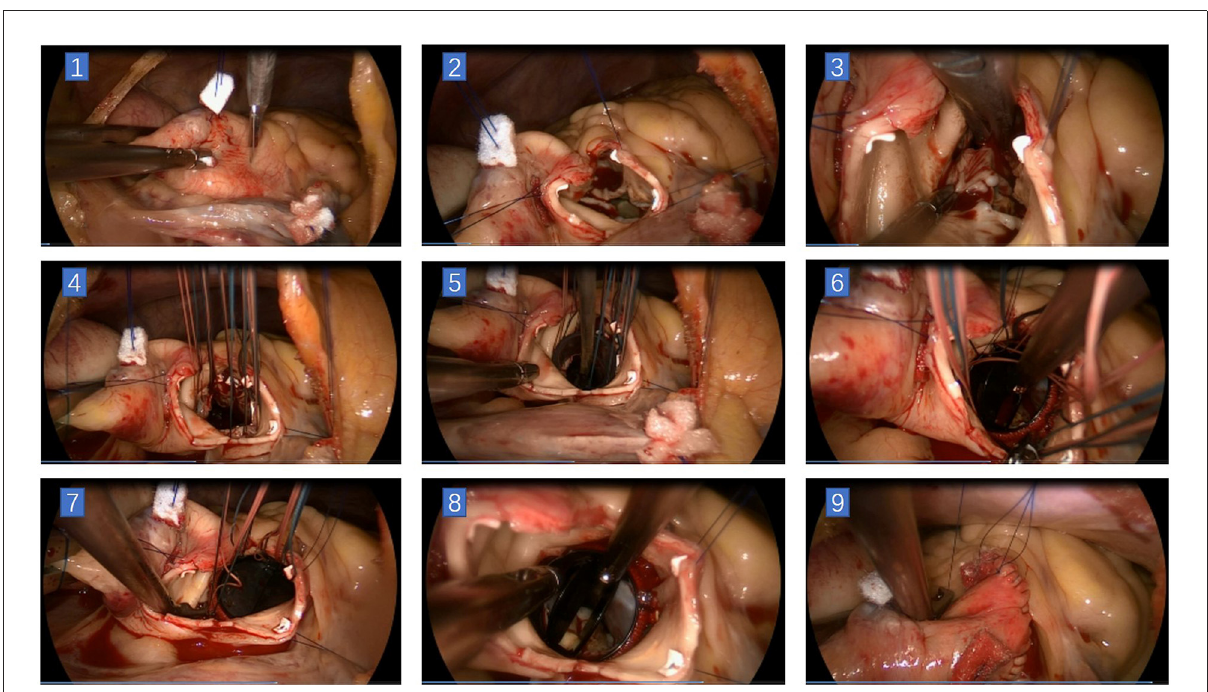
FIGURE3 Main steps of total endoscopic aortic valve replacement. (1) Incision on ascending aorta. (2) The aortic incision was extended toward the right/left commissural on the left side and to the non-coronary sinus near the left/non-commissural on the right side. A stitch was placed at the center of the superior edge, and two stitches were placed at the inferior edge of the aortic incision. (3) Resection of the aortic leaflets. (4) 2–0 polyester stitches with pledges were used for intermittent sutures of the prosthesis. (5) Seating the prosthesis valve. (6) Knotting could be done in the order of first non-coronary annulus, then left coronary annulus, and finally right coronary annulus with a unique minimally invasive knot pusher. (7) Remove the stitches in the same previous order. (8) Check the status of the prosthesis. (9) Close the aortic